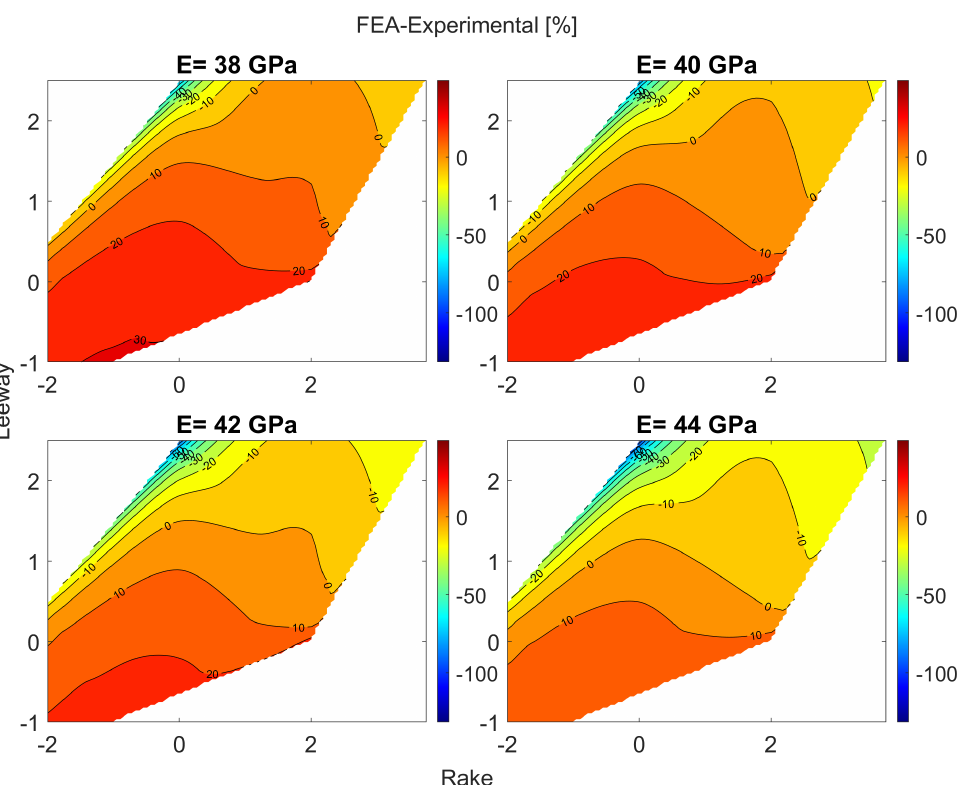
Figure 36. Impact on average displacement with respect to the Young’s